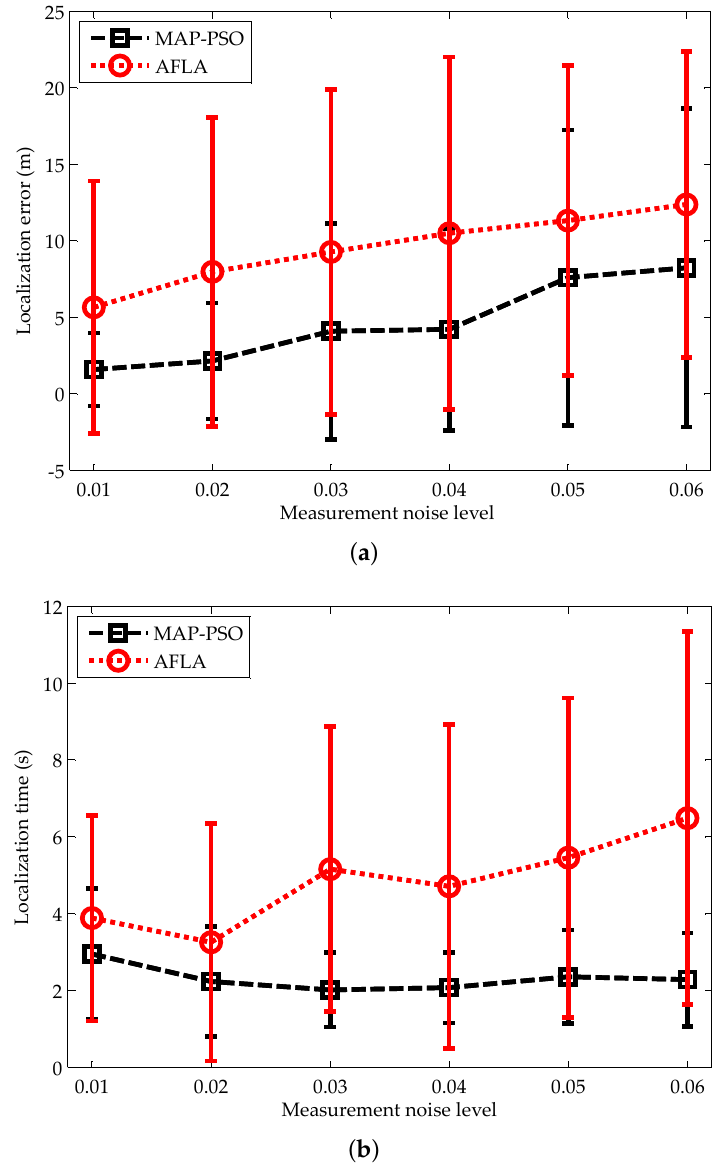
Figure 8. Impacts of the measurement noise level on: ( a ) localization accuracy; ( b ) localization